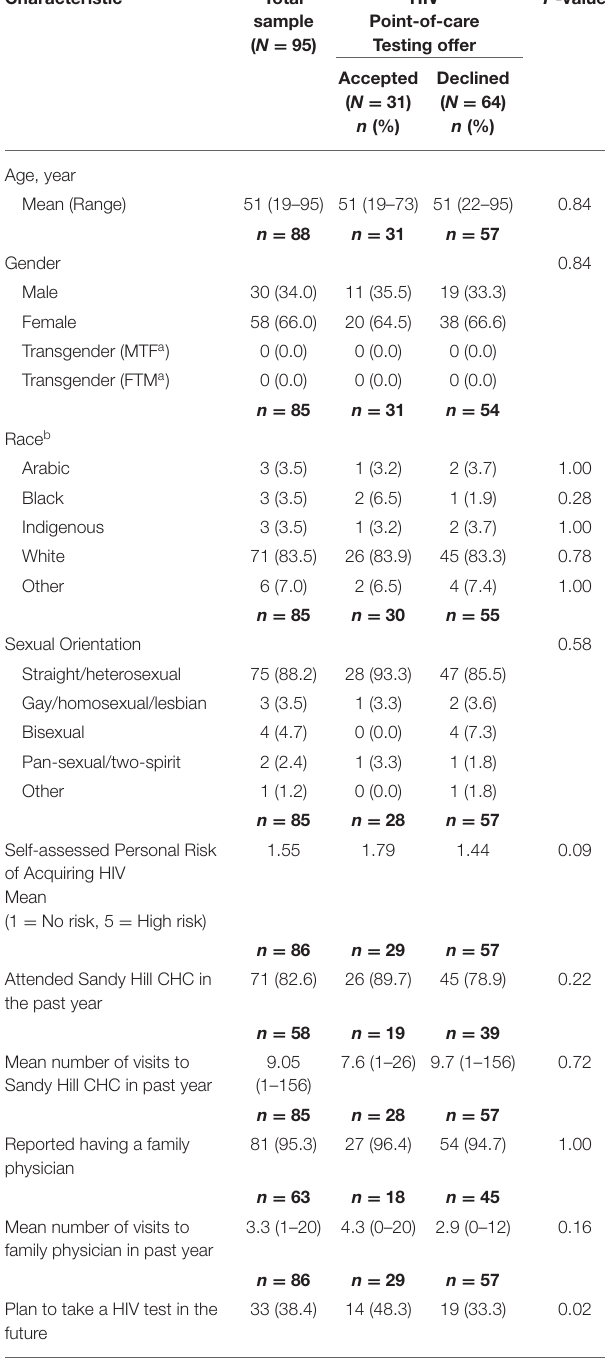
TABLE 1 | Profile of Patients Completing Acceptability